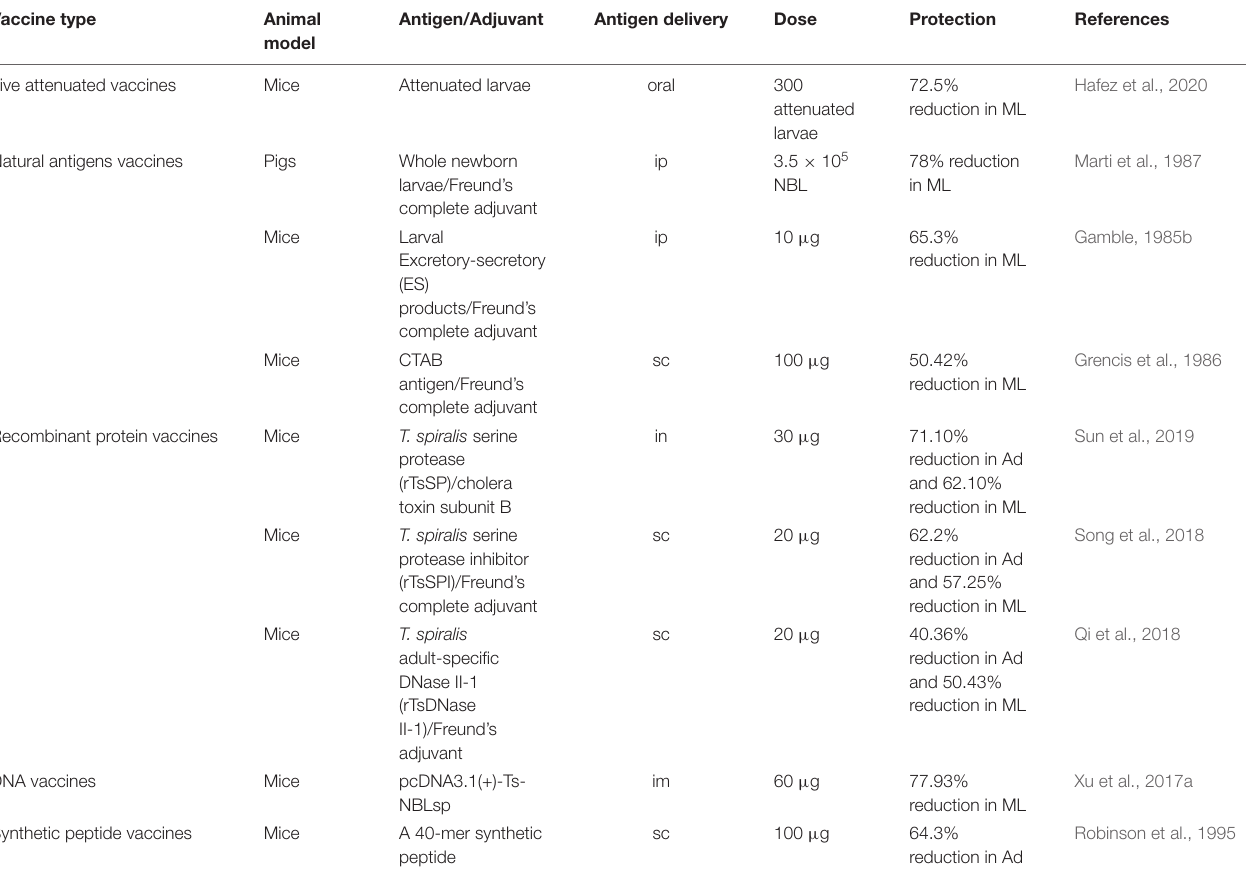
TABLE 1 | The protective effect of different type vaccines against Trichinella spiralis